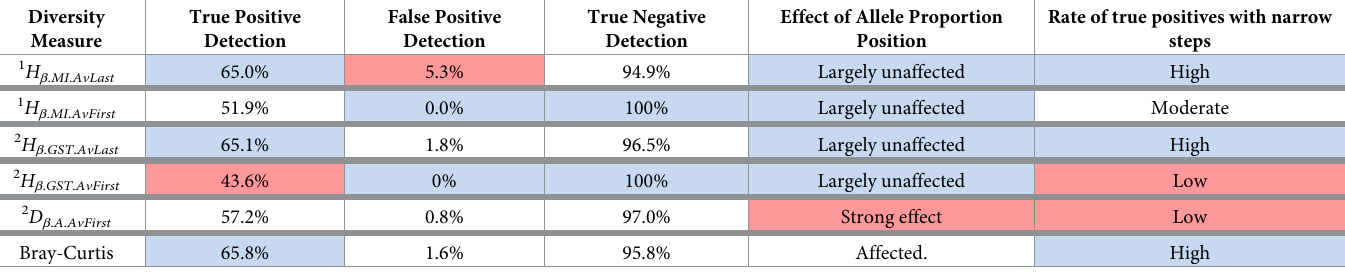
Table 4. Summary of properties of each of the six best candidate measures—Mutual Information ( AvLast and AvFirst variants), G ST ( AvLast and AvFirst variants), 2 D β .A ( AvLast variant) and Bray-Curtis. Note that we detail the properties of Mutual Information here, but the properties are the same for each of the other q = 1 mea- sures. ‘True Positive Detections’ was calculated as the percentage of true positives across all step simulations. ‘False Positive Detections’ was calculated as the percentage of false positives across all simulations. ‘True Negative Detections’ was calculated as the percentage of true negatives across all linear simulations. Properties are shaded based on their usefulness as a step detection measure: most desirable properties (blue), undesirable properties